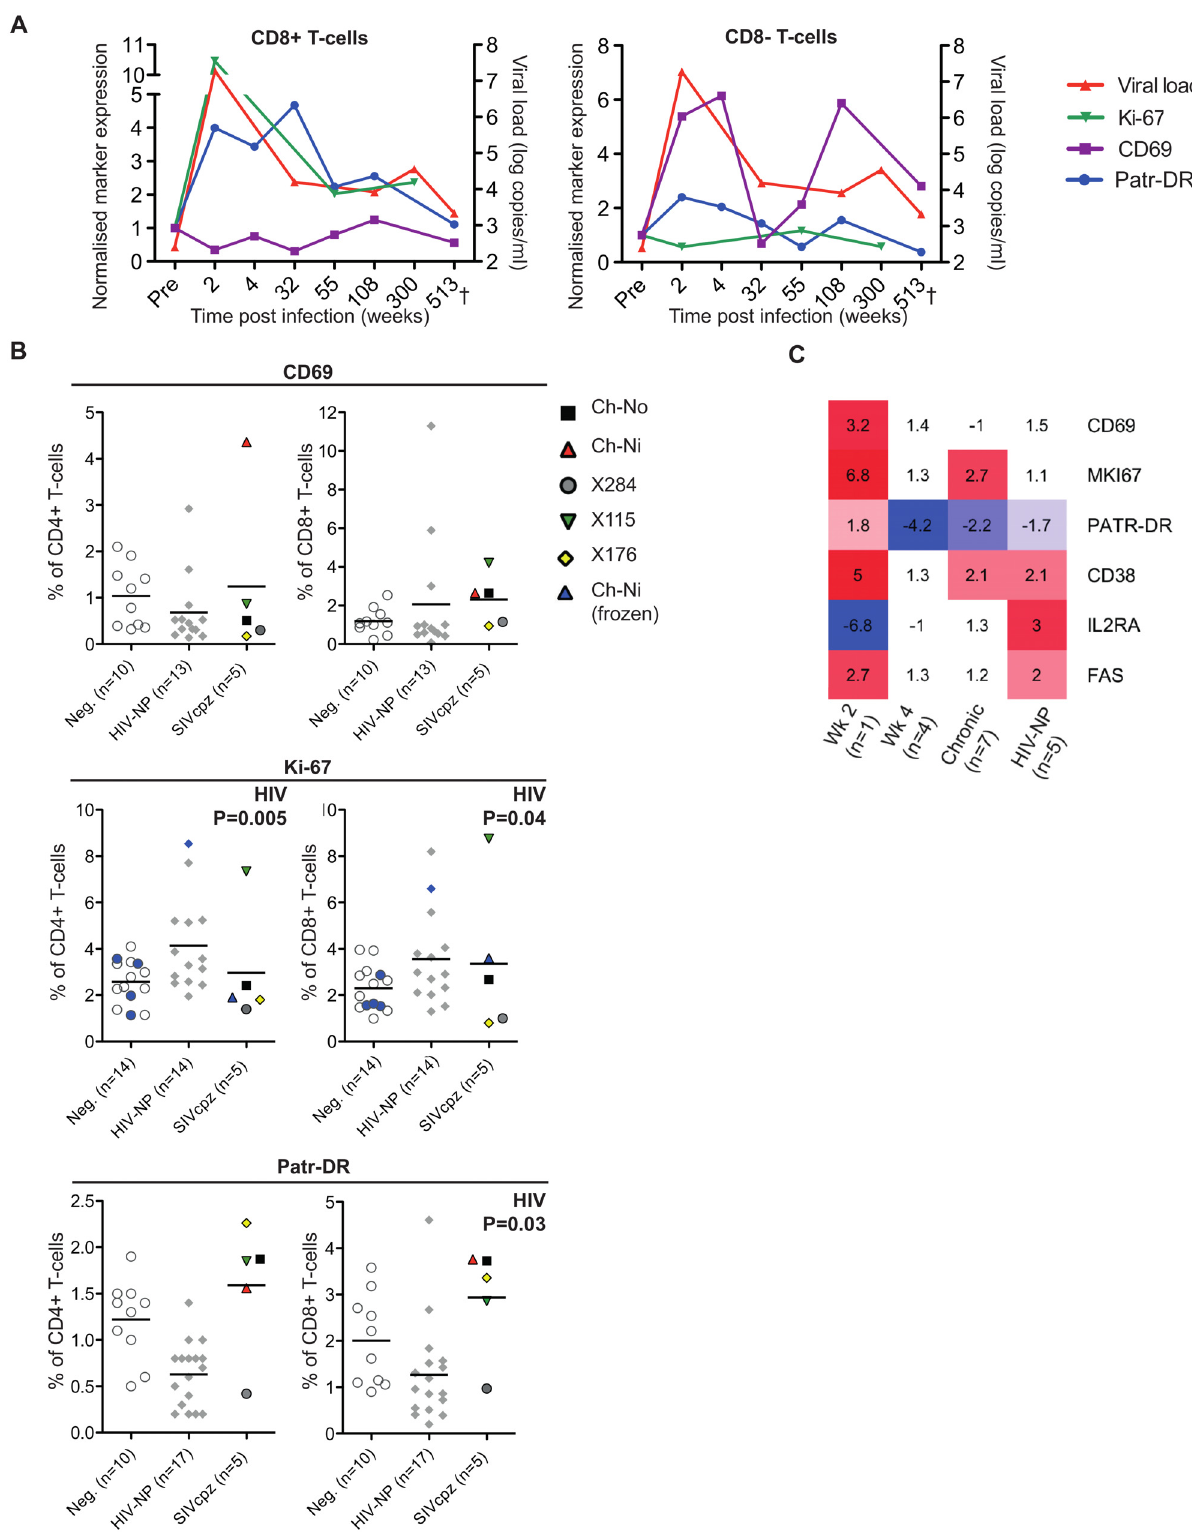
Fig 2. Peripheral blood T-cell activation in SIVcpz infected animals. (A) Longitudinal measurements of T-cell activation in the CD8+ and CD8- T-cell populations of the animal Ch-Ni. Each marker was normalised to pre-infection values: data is expressed as fold change compared to this. Viral load is shown